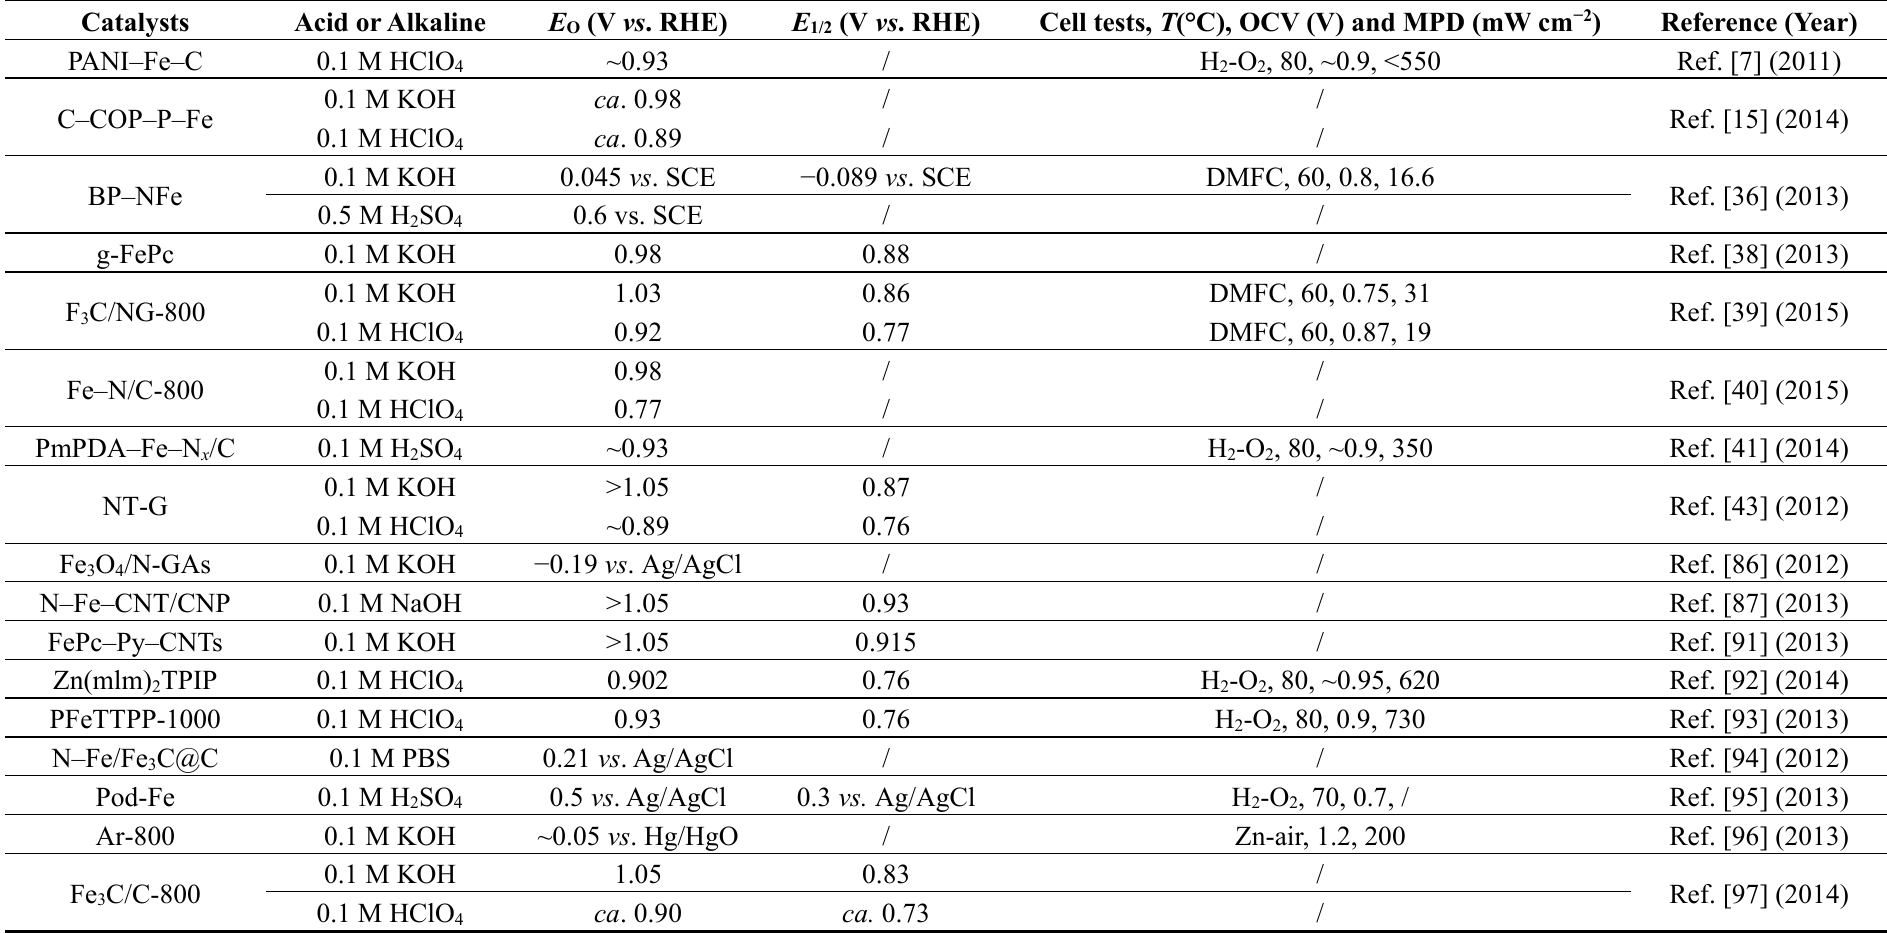
Table 1. Electrocatalytic performance (onset potential ( E o /V vs . RHE) and half-wave potential ( E 1/2 /V vs . RHE)) of recently reported Fe-based catalysts for ORR and the corresponding test results ( T /°C, test temperature; OCV/V, open-circuit voltage; MPD/mW cm − 2 , and